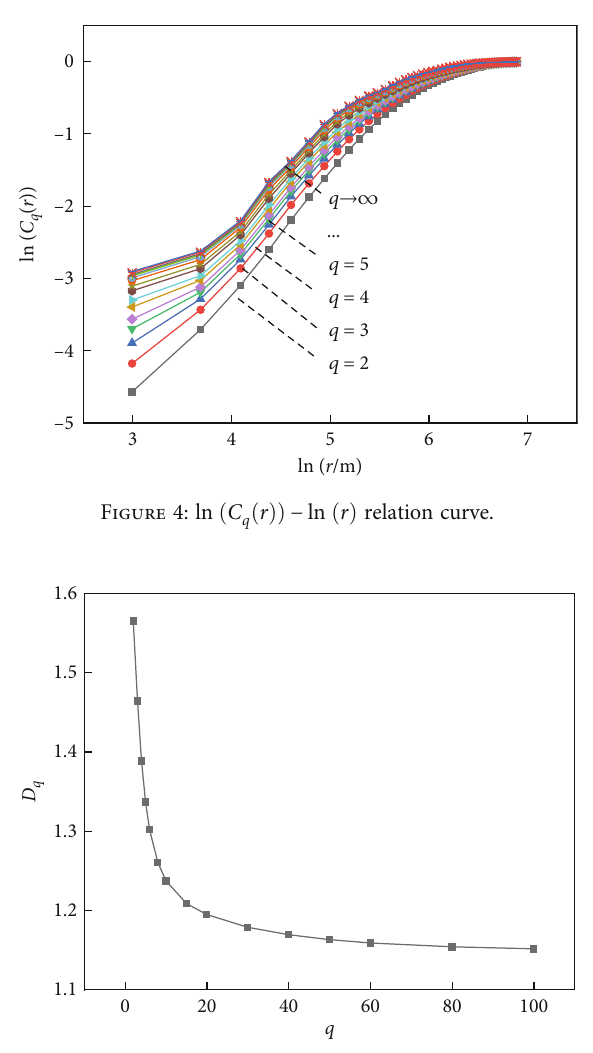
Figure 5: The changing trend diagram of D